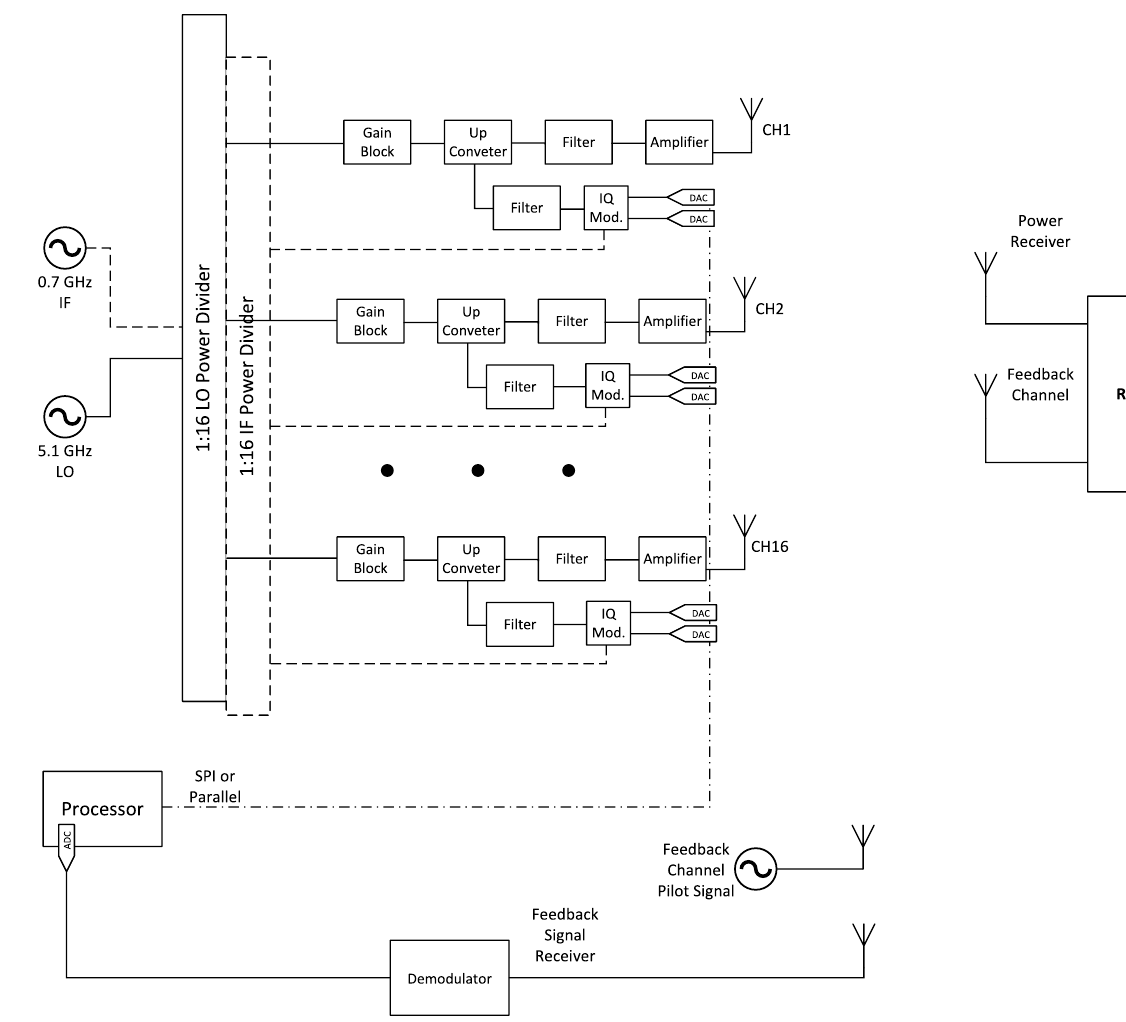
Figure 2. Block Diagram of High-Power Wireless Power Transmitter.